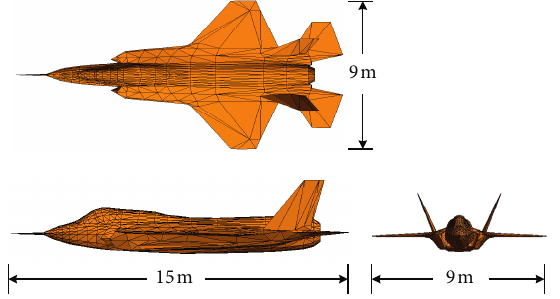
Figure 5: Geometry of the airplane model.